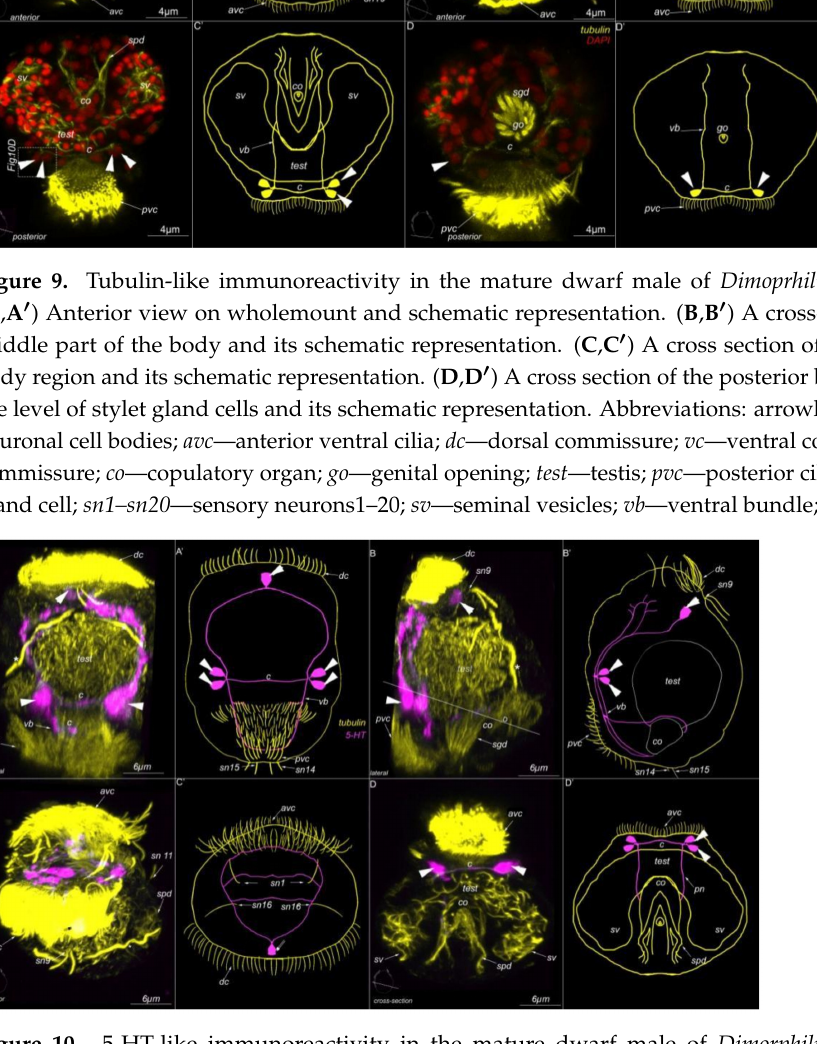
Figure 10. 5-HT-like immunoreactivity in the mature dwarf male of Dimorphilus gyrociliatus. ( A , A (cid:48) ) Ventral view on wholemount. ( B , B (cid:48) ) lateral view on wholemount. ( C , C (cid:48) ) dorsal view on wholemount. ( D , D (cid:48) ) A cross section of the posterior body region as indicated in ( C , C (cid:48) ) Abbreviations: arrowheads indicate neuronal cell bodies; avc —anterior ventral cilia; c —commissure, dc —dorsal cilia; test —testis, pn —penial nerve; pvc —posterior cilia; sgd —stylet gland cell; spd —spermioduct; sn1–sn20 —sensory neurons1–20; sv —seminal vesicles; vb —ventral bundle;